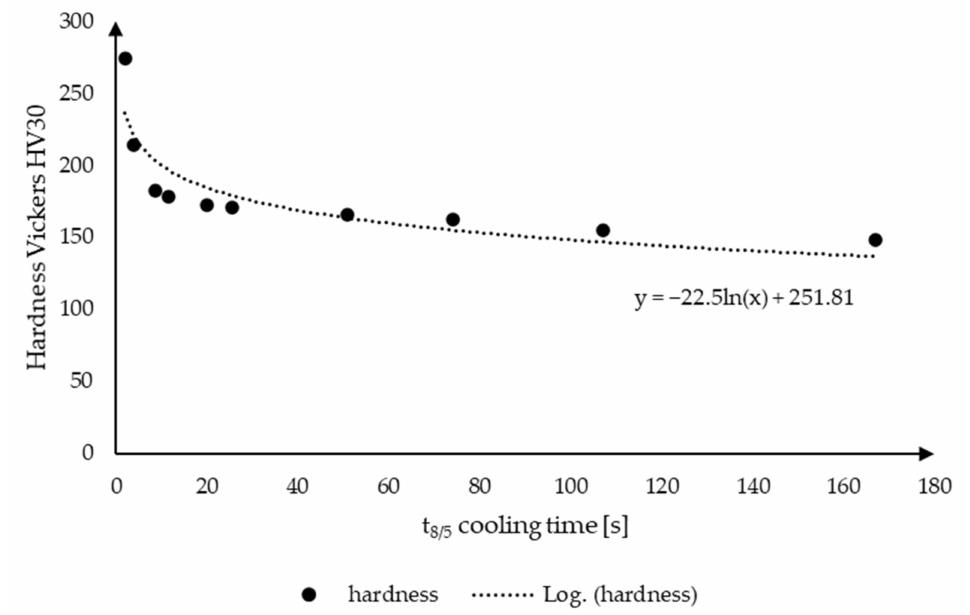
Figure 8. Hardness as a function of t 8/5 cooling time (values for hardness and t 8/5 cooling time according to the welding TTT diagram shown in Figure